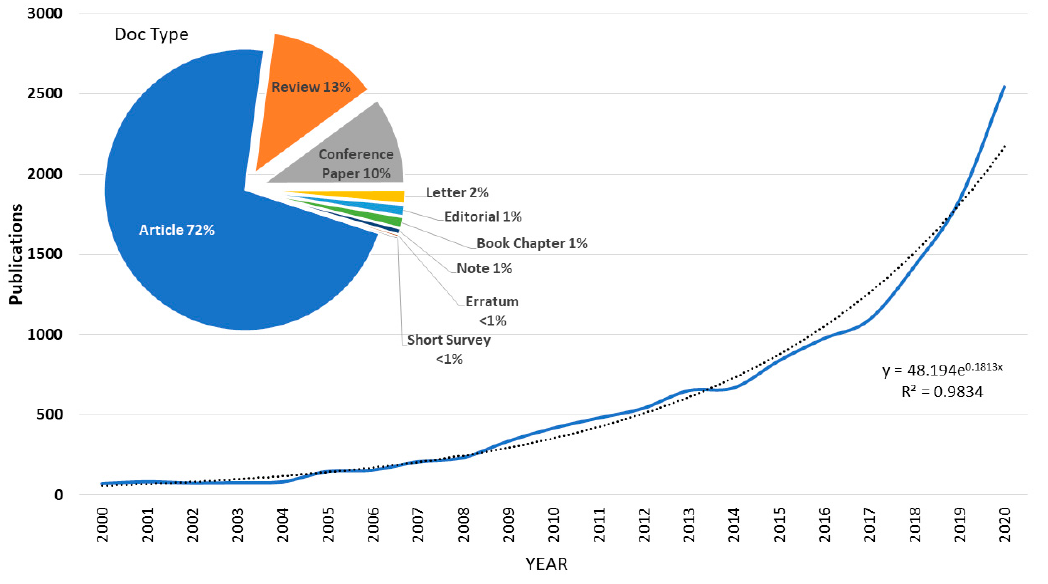
Figure 2. Bibliometric publications trend (Source Scopus).